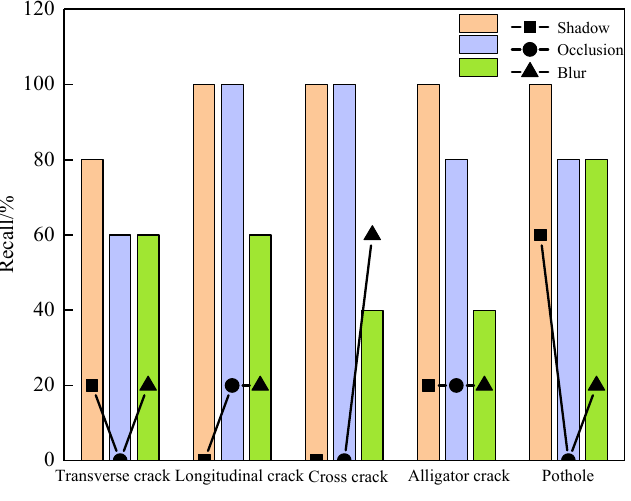
Figure 13. Recall of YOLOv5 network trained on the integrated dataset with the best virtual-to-real ratio of 3:1 for three adverse-detection scenarios.